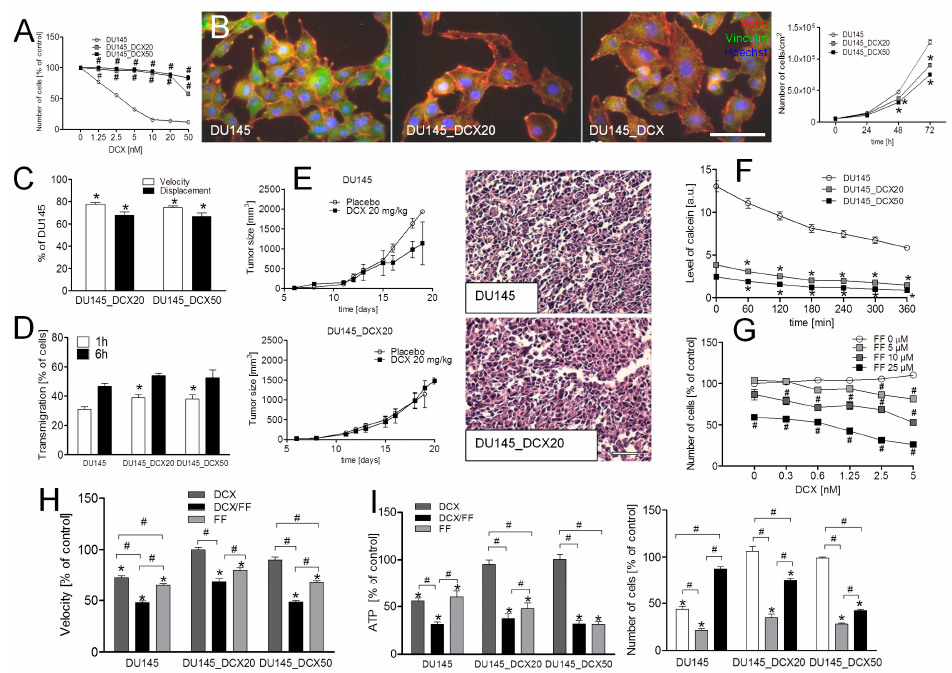
Figure 2. FF interferes with the DCX-resistance of DU145 cells. ( A ) Naïve DU145 and DCX-resistant DU145 cells (DU145_DCX20 and DU145_DCX50; cf. Figure S3 in Supplementary material) were